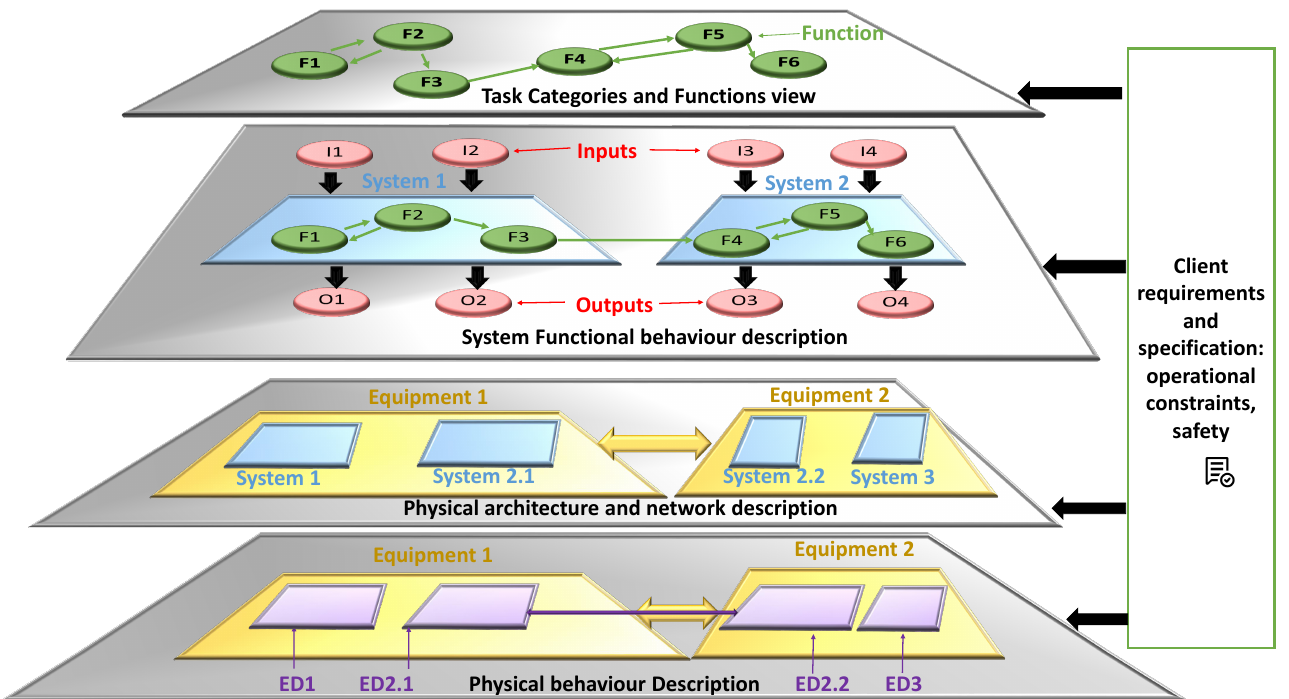
Figure 5. The different levels of abstraction of the proposed I&C